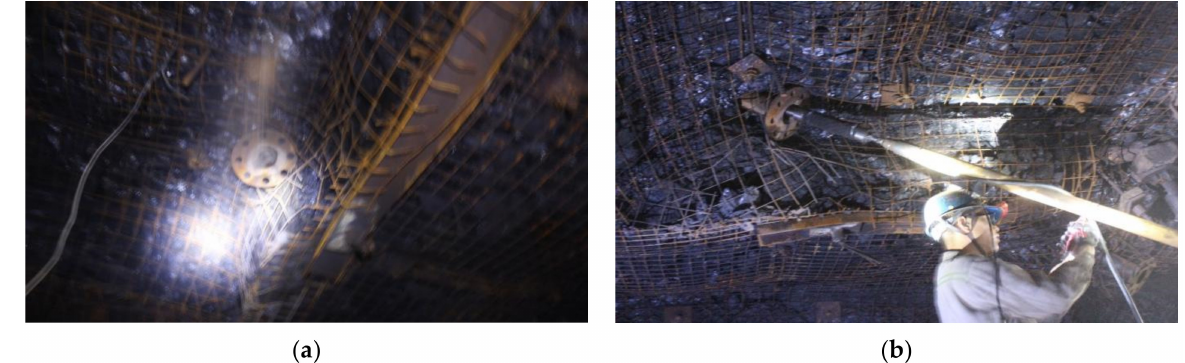
Figure 3. Borehole layout.